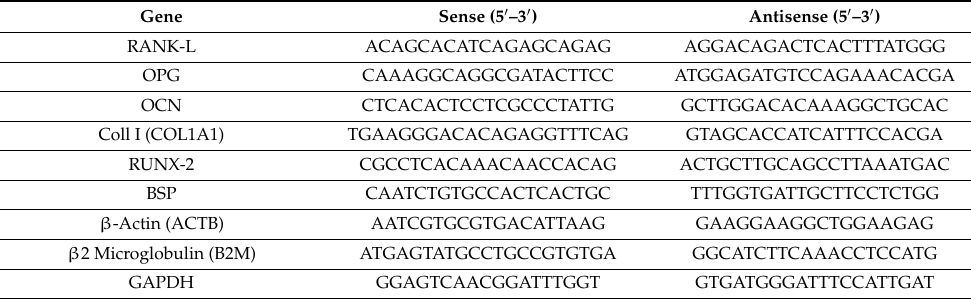
Table 1. List of primer sequences used for